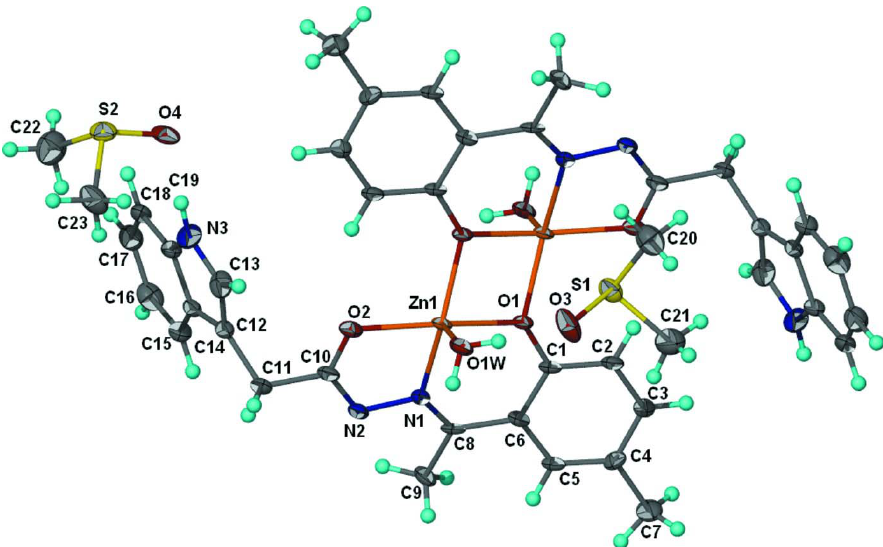
Figure 1 Thermal ellipsoid plot (Barbour, 2001) plot of the dinuclear compound at the 70% probability level. Hydrogen atoms are drawn as spheres of arbitrary radius. The compound lies about a center of inversion, and unlabeled atoms are related to their labeled equivalents by 1 – x , 1 – y , 1 – z